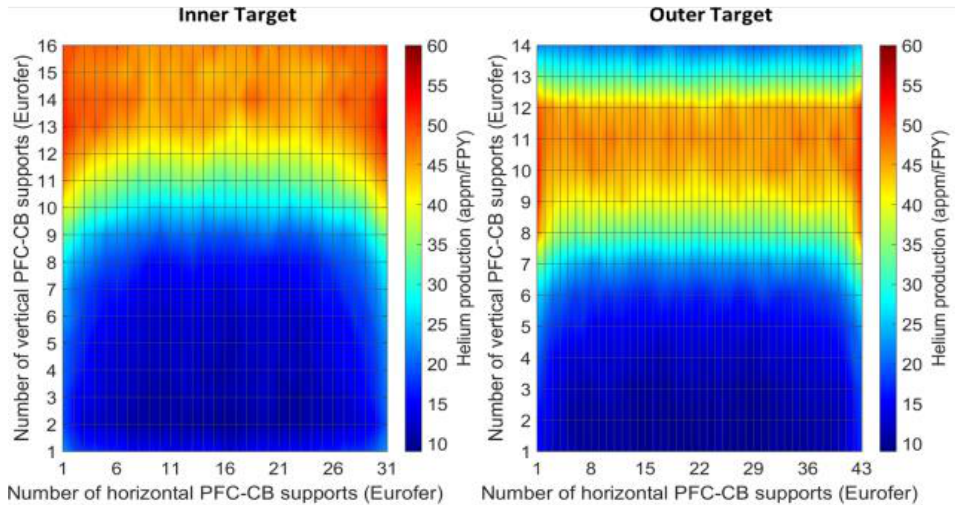
Figure 27. He-production (appm/FPY) distribution on PFC-CB supports (Eurofer) of the inner ( left ) and outer ( right ) target, with WCLL blanket.